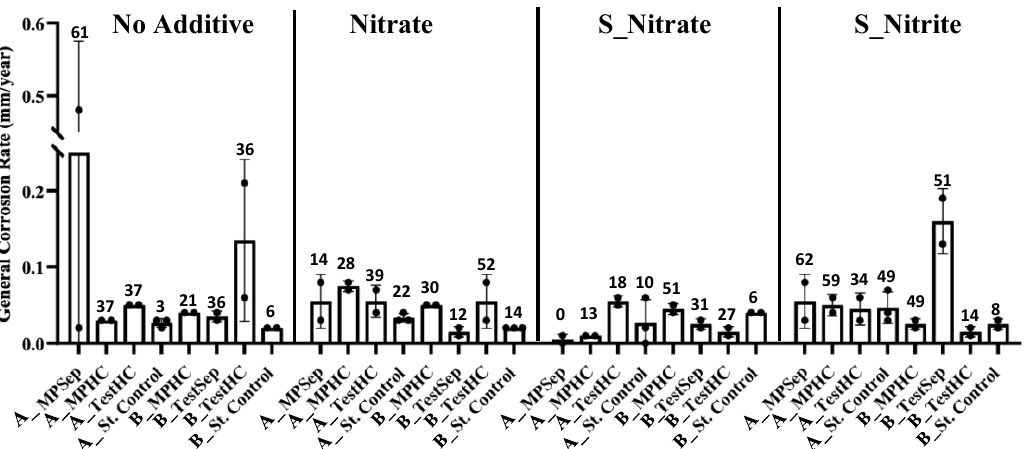
Figure 6. General corrosion rates calculated for the coupons in microcosms from each sampling location and treatment. The bars represent the mean general corrosion rates of two replicates ( n = 2) and the error bars represent the standard error between replicates. The number displayed above each bar is the highest pitting frequency observed among the replicates in the corresponding treatment and sampling locations.